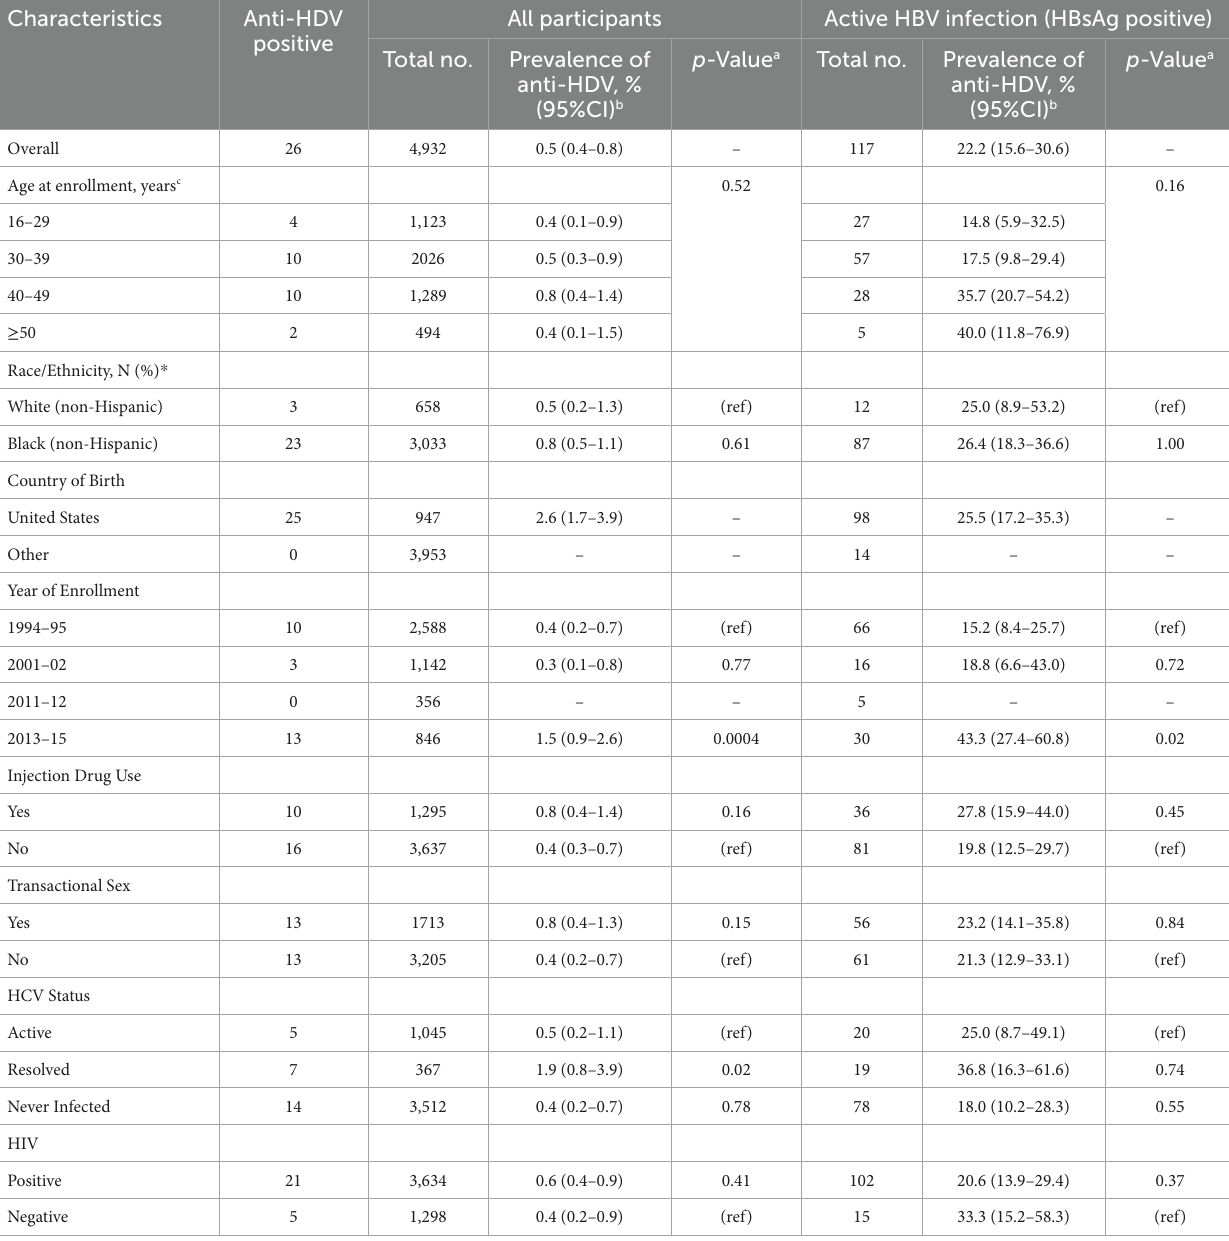
TABLE 2 Prevalence of HDV antibody among WIHS participants, by selected demographic, behavioral and clinical characteristics.